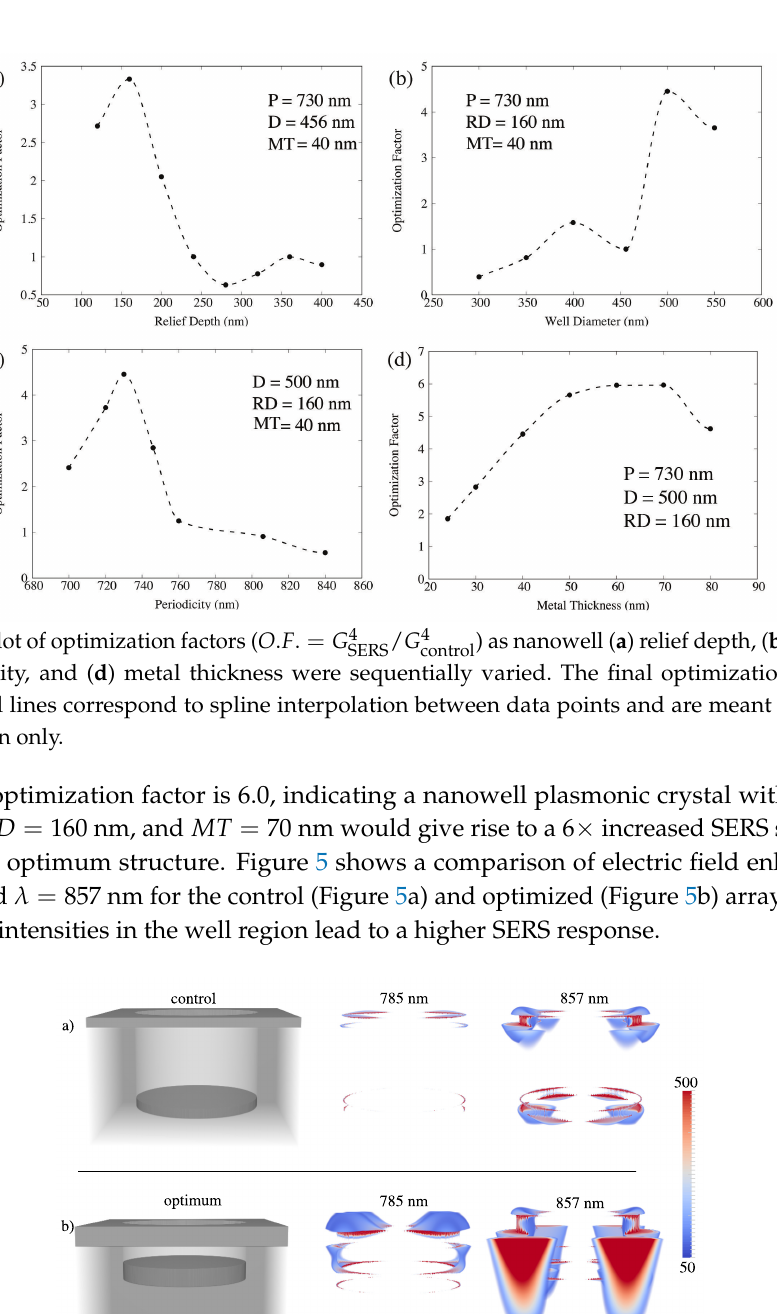
Figure 5. Plot of dielectric constant and time-averaged electric field intensity enhancements ( g 2 = | E | 2 / | E 0 | 2 ) at λ = 785 nm and λ = 857 nm for ( a ) unit cell of control NW geometry ( D = 456 nm, P = 730 nm, RD = 360 nm, and MT = 40 nm) and ( b ) unit cell of optimized NW geometry ( D = 500 nm, P = 730 nm, RD = 160 nm, and MT = 70 nm). Only enhancements in the 50–500 range are